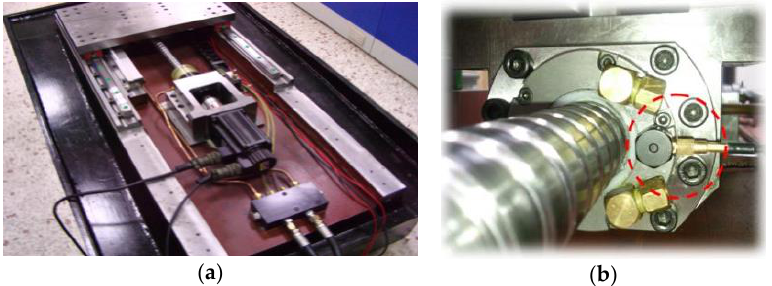
Figure 1. ( a ) Picture of the in-house single-axis platform with a servo motor and linear scale positioning sensor, and ( b ) picture of the acceleration sensor attached to the ball nut (right).